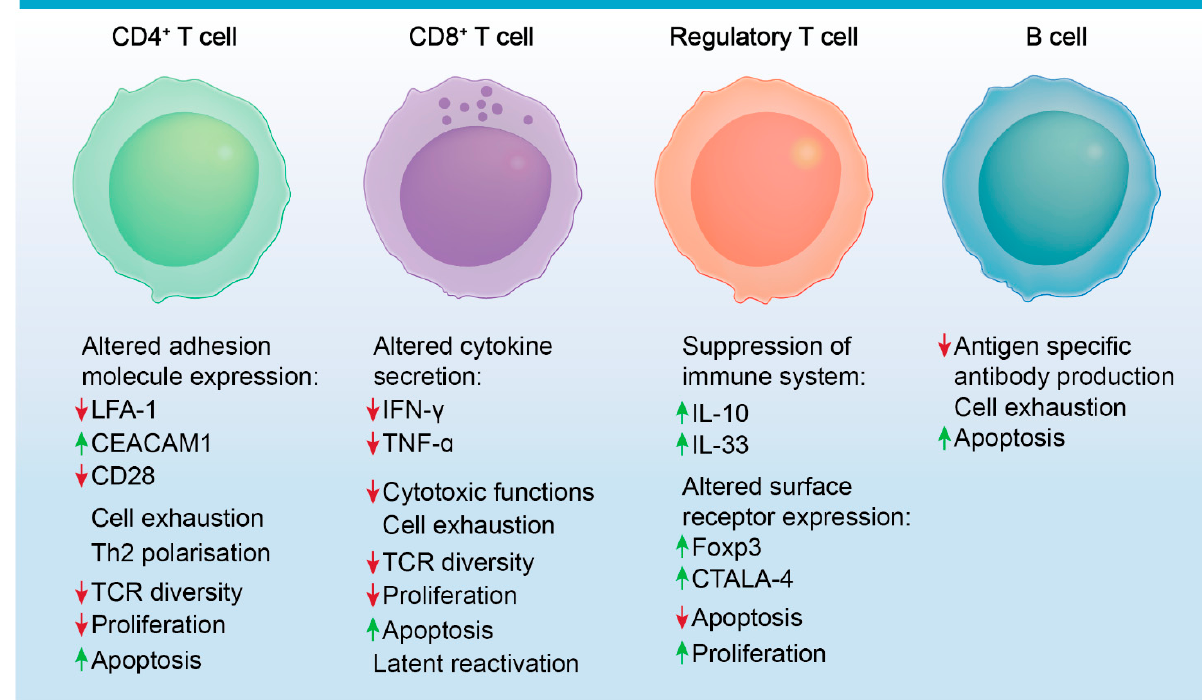
Figure 2. Sepsis-induced immune dysregulation and suppression of adaptive immune cells. Altered adhesion molecule expression is noted in CD4 + T cells following sepsis [95,96]. CD4 + cells lack appropriate functions post-sepsis due to down- regulation of TCRs. They also undergo marked apoptosis, as do CD8 + T cells. CD8 + T cells have altered cytokine secretion and decreased cytotoxic functions post-sepsis [6,97]. T regs are the only known lymphocyte to proliferate during sepsis and exacerbate immune suppression during disease pathogenesis [98,99]. The role of B cells is not well defined in the context of sepsis; however, antigen-specific antibody production is compromised, and the cells become increasingly apoptotic during sepsis [50].